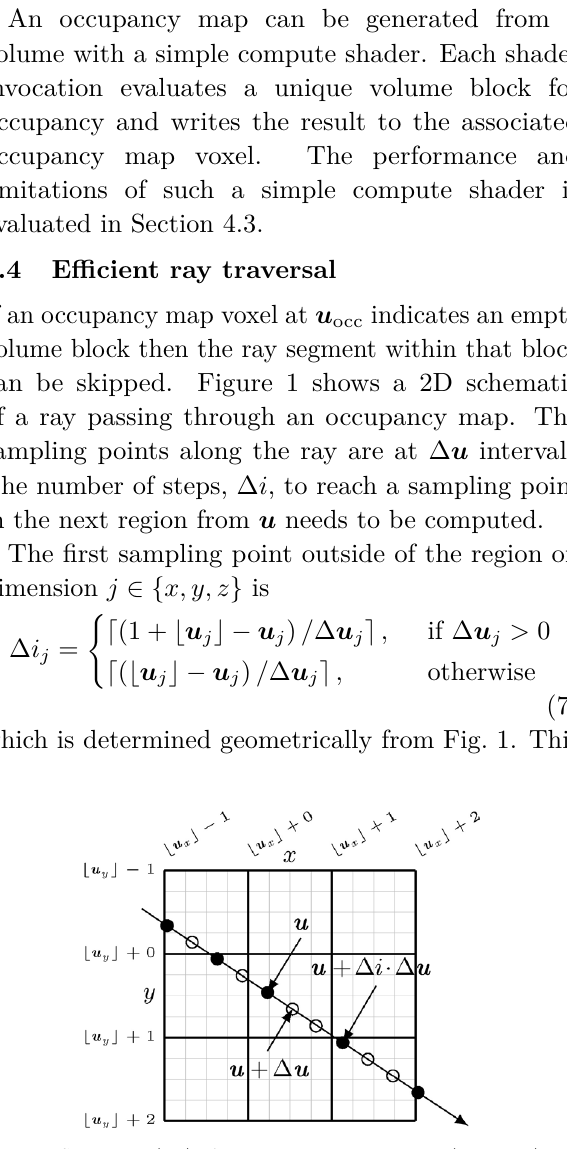
Fig. 1 Schematic (2D) of a ray traversing a volume (grey grid) and its occupancy map (black grid) with B = (4 , 4). The filled points are sampled on the occupancy map. Filled and unfilled points are sampled on the volume in occupied